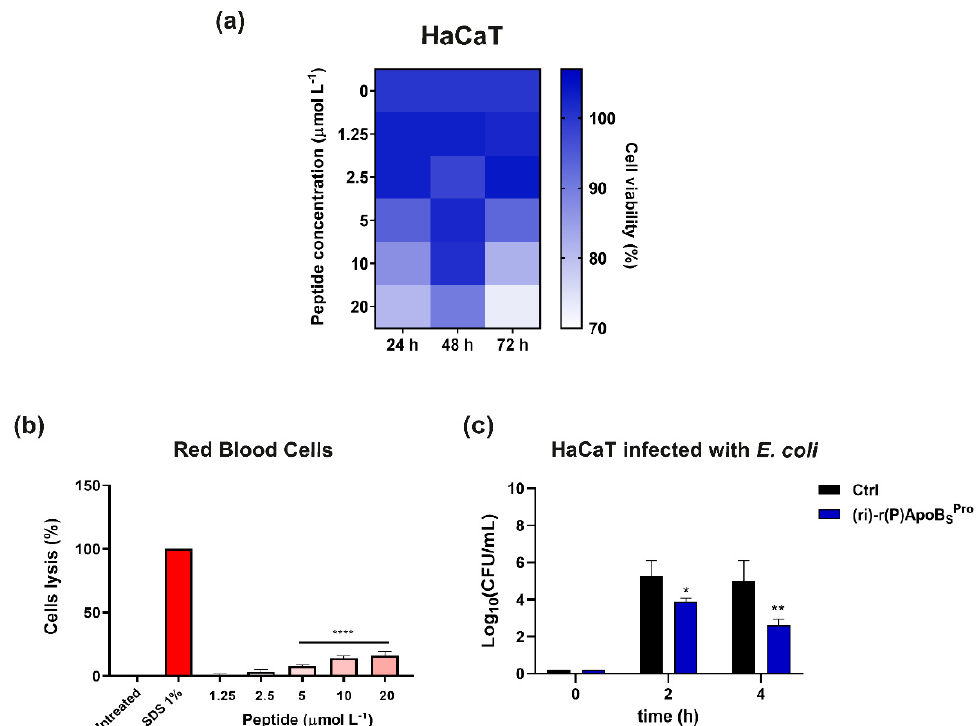
Figure 3. Effects of retro-inverso synthetic peptide on human eukaryotic cell lines. ( a ) Cytotoxic effects of increasing concentrations of (ri)-r(P)ApoB SPro on HaCaT (immortalized human keratinocytes) cells. Cell viability was assessed by MTT assays and expressed as the percentage of viable cells compared to untreated cells (control). ( b ) Analysis of hemolytic effects of (ri)-r(P)ApoB SPro toward human red blood cells (RBCs) after 1 h of incubation at 37 ◦ C. Data represent the mean ( ± standard deviation, SD) of at least three independent experiments, each one carried out with triplicate determinations. ( c ) Effects of (ri)-r(P)ApoB SPro peptide on the adhesion of E. coli bacterial cells to HaCaT cells. Experiments were performed three times in duplicate. Error bars represent the standard deviation of the mean. Significant differences were indicated as * p < 0.05, ** p < 0.01 or **** p < 0.0001 for treated vs. control